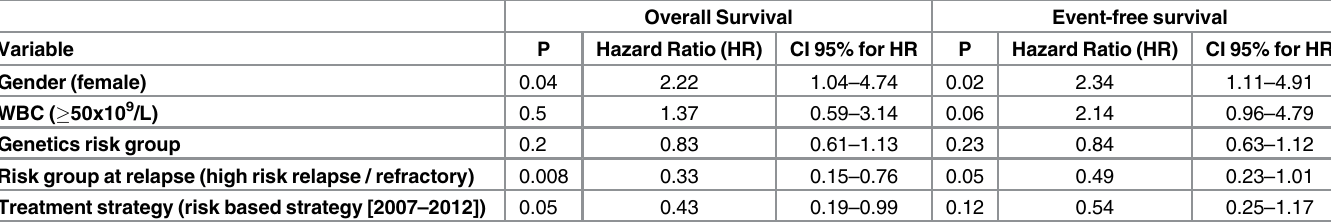
Table 3. Multivariate analysis of survival and event free survival for relapsed or refractory ALL.